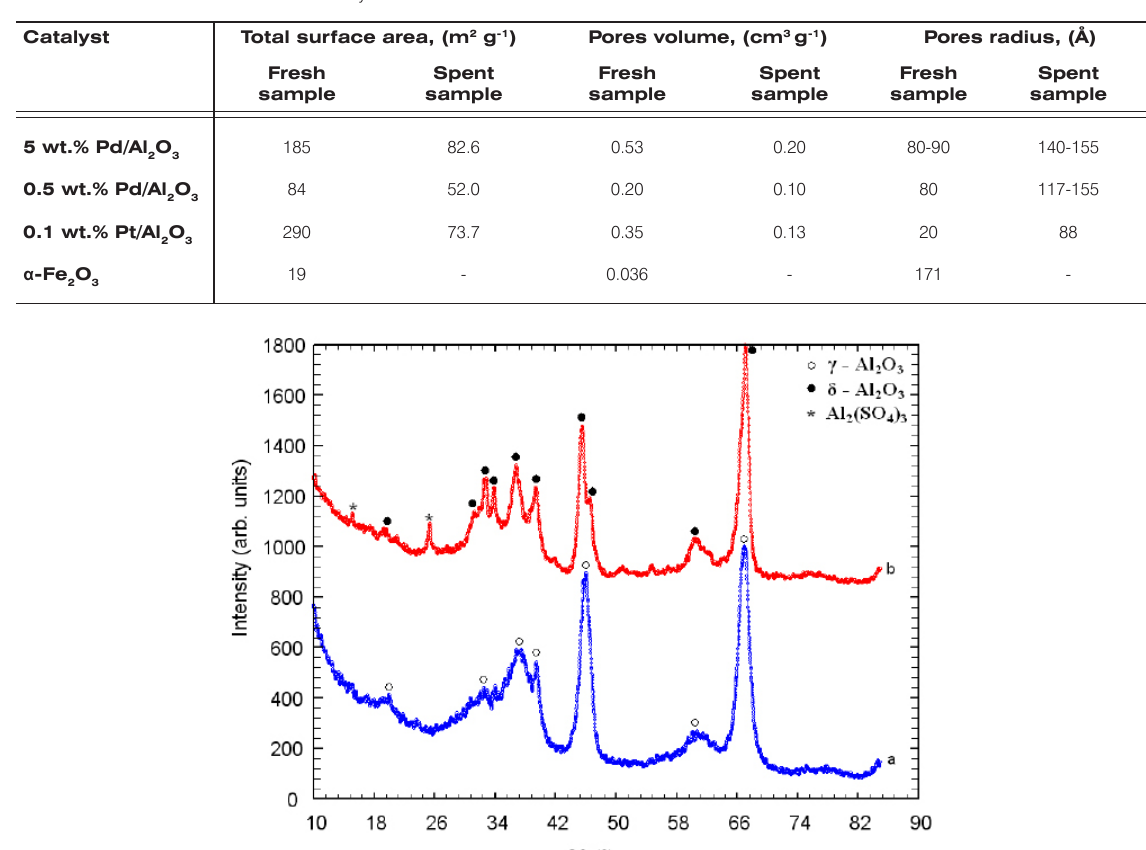
Figure 4. X-ray diffraction patterns of 5 wt.% Pd/Al